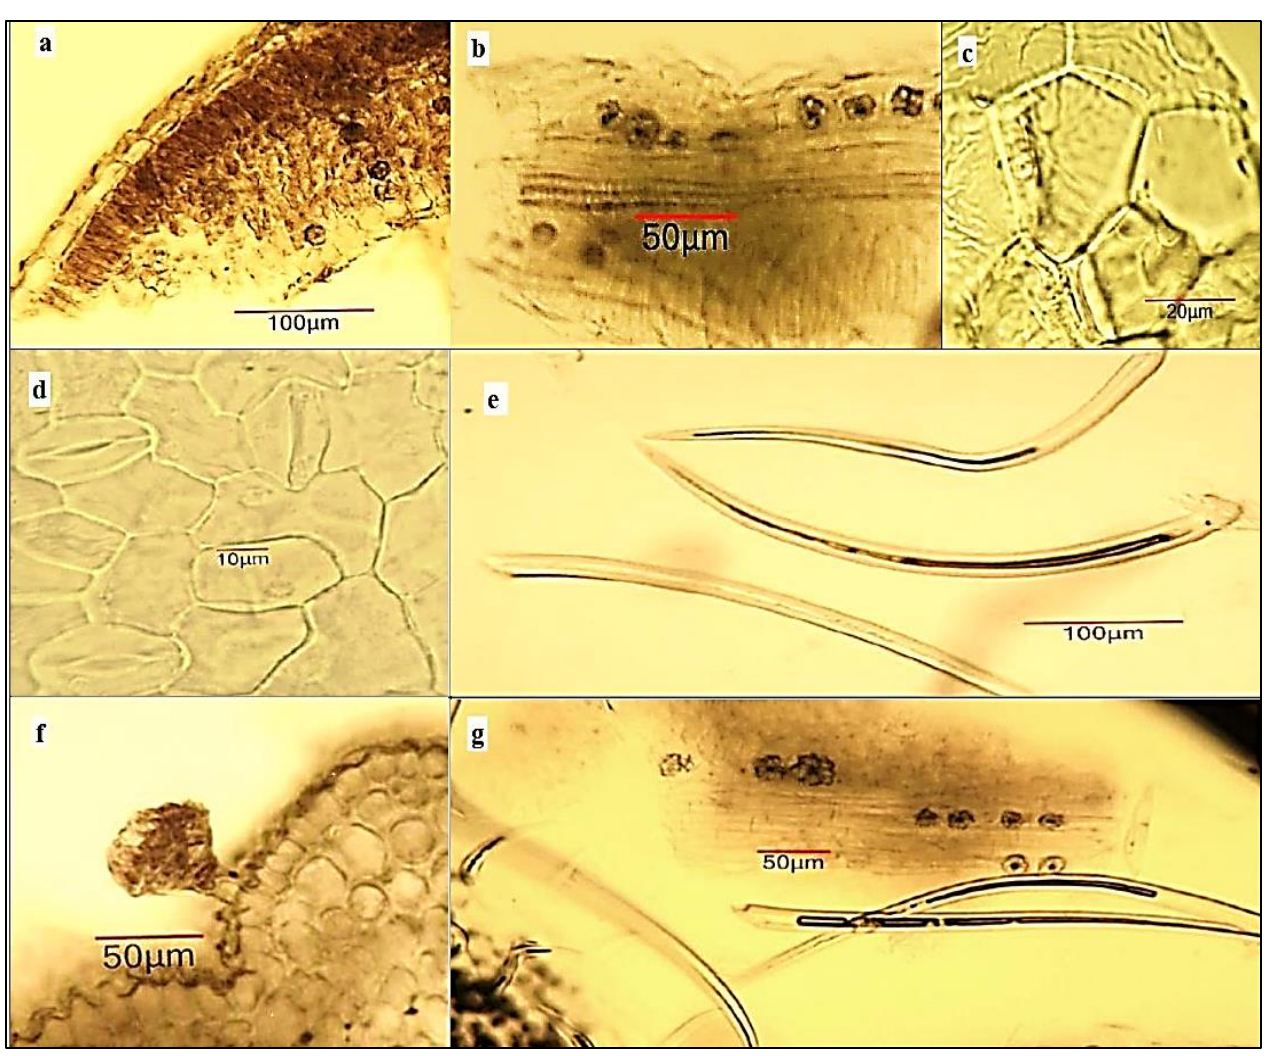
Figure 4. Microphotos of powdered leaf substance of Ailanthus altissima : ( a ) fragment of the bifacial leaf lamina in cross section with 1 – 2 layers of palisade parenchyma, spongy parenchyma and crystalline druses of calcium oxalate; ( b ) oxalate druses around the vascular bundle; ( c ) upper leaf epidermis in surface view; ( d ) lower leaf epidermis in surface view with anomocytic type of stomata; ( e ) isolated unicellular curved covering trichomes; ( f ) glandular head trichome along vein; ( g ) unicellular covering trichomes and fragment of spongy parenchyma with oxalate druses.